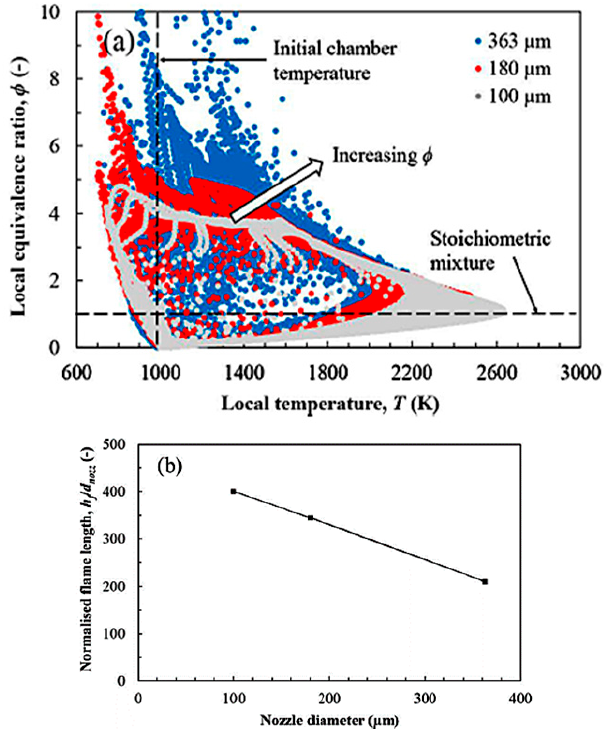
Figure 31. Comparisons of ( a ) ϕ -T characteristics at 0.5 ms after ignition and ( b ) normalized flame lengths for different nozzle diameters [38].